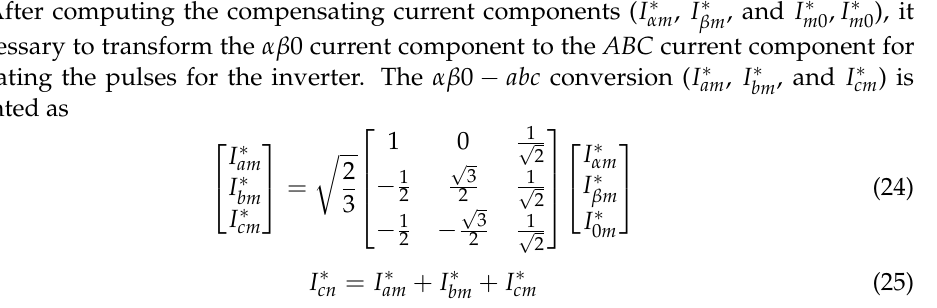
(𝑠) at different bandwidths and ( b ) 𝐻 𝑉 Figure 5. Bode diagram of ( a ) 𝐺 𝑉 ( s ) at different bandwidths and ( b ) H 𝑑𝑐 dc K i values.